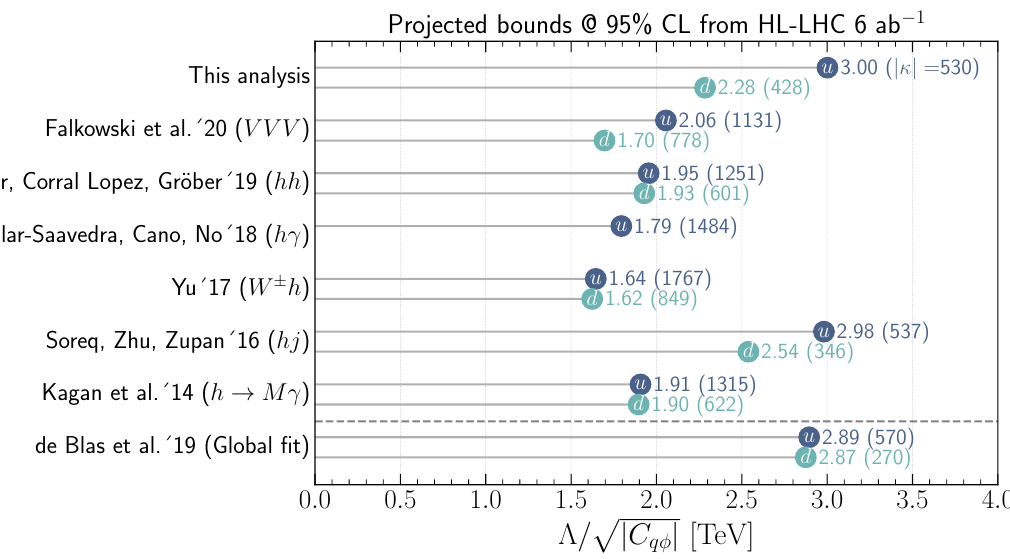
Figure 10 . Summary of the 95% CL sensitivity bounds on the SMEFT Wilson coefficients C uφ (blue), and C (green). The bounds are interpreted in terms of the NP scale Λ that can be reached dφ through the measurements of the Wilson coefficient at the HL-LHC at 6 ab − 1 , the corresponding κ q ’s are shown inside the parentheses. The 95% CL bounds from single parameter fits are used from this analysis for comparison with previous